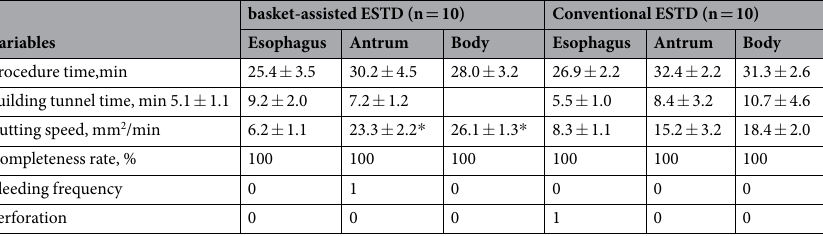
Table 1. Statistical Analysis of Procedural Data. Data are presented as mean ± SD. * p < 0.05 compared with the Conventional